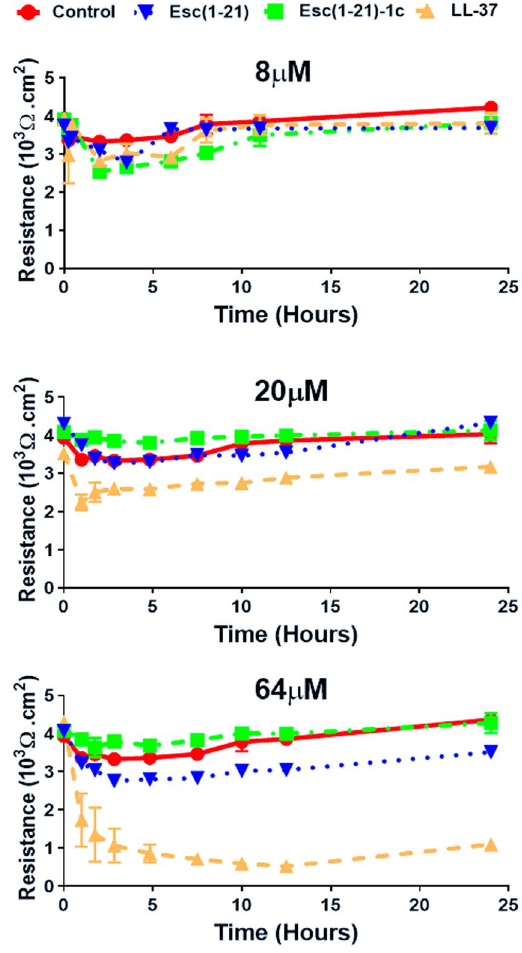
Figure 1. Effects of AMPs on the TEER of lung epithelial cells. Peptides in PBS were added to the apical compartment of the normal primary human bronchial epithelial cells maintained in ALI condition. TEER was measured at multiple time points (1, 2, 3, 5, 8, 10, 12 and 24 hours). Results are representative data from three independent